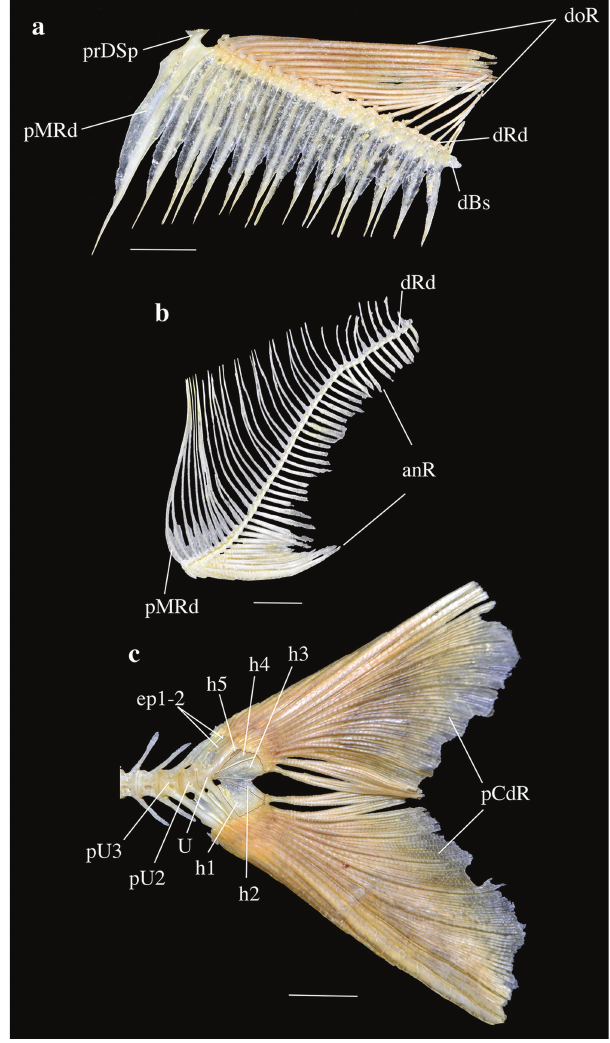
Fig. 6. Axial skeleton of Metynnis melanogrammus , INPA 18457, 144.8 mm SL: a. dorsal fin, left lateral view; b. anal fin, left lateral view; c. caudal fin, left lateral view; d. abdominal spines, left lateral view; e. abdominal spines, dorsal view. anR , anal-fin rays; blSp , bilateral spine; bpt , basipterygium; dBs , dorsal bony stay; doR , dorsal-fin rays; dRd , distal radial; ep1-2 , epural 1-2; h1-5 , hypural 1-5; pCdr , principal caudal- fin rays; pMRd , proximal-middle radial; poPvSp , post- pelvic spines; prDSp , predorsal spine; prPvSp , prepelvic spines; pU2-3 , preural centrum 2-3; pvR , pelvic-fin rays; U , compound ural centrum. Scale bars: 10 mm.